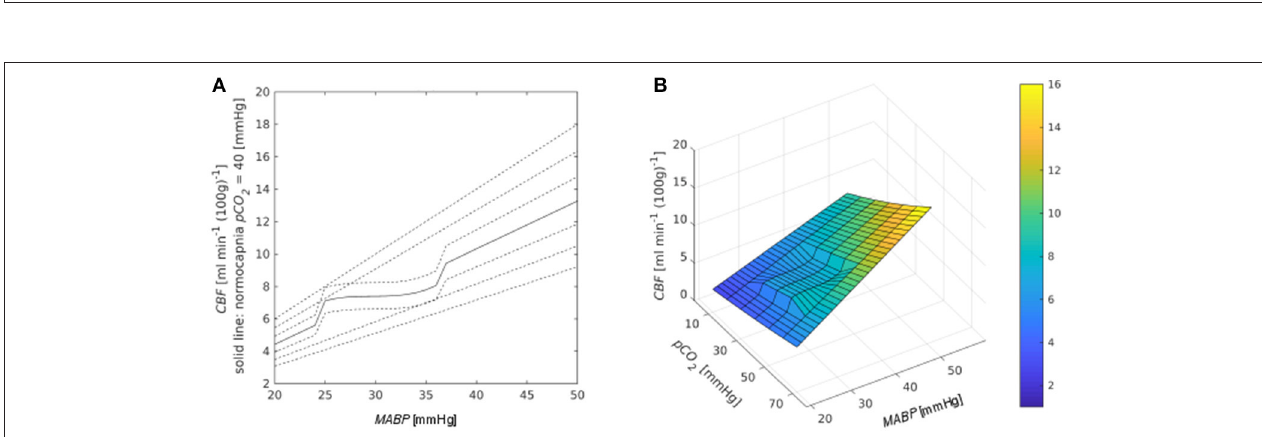
FIGURE 2 | (A) Mean MABP for the control (blue lines) and risk (red lines) groups for the first day (dashed lines) and for the following days (solid lines); (B) polynomial approximation (lines without symbols) to the average pressure MABP ref obtained from the clinical records (lines with symbols) in the control group for the first day (green curves) and for the period after the first postnatal day (blue curves).